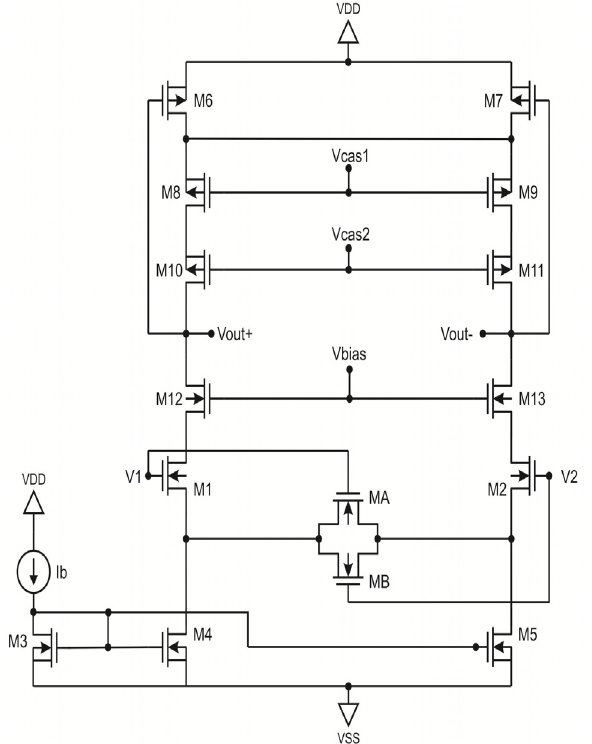
Fig.2: Schematic diagram of the simulated CMOS class-A operational transconductance amplifier (modified from